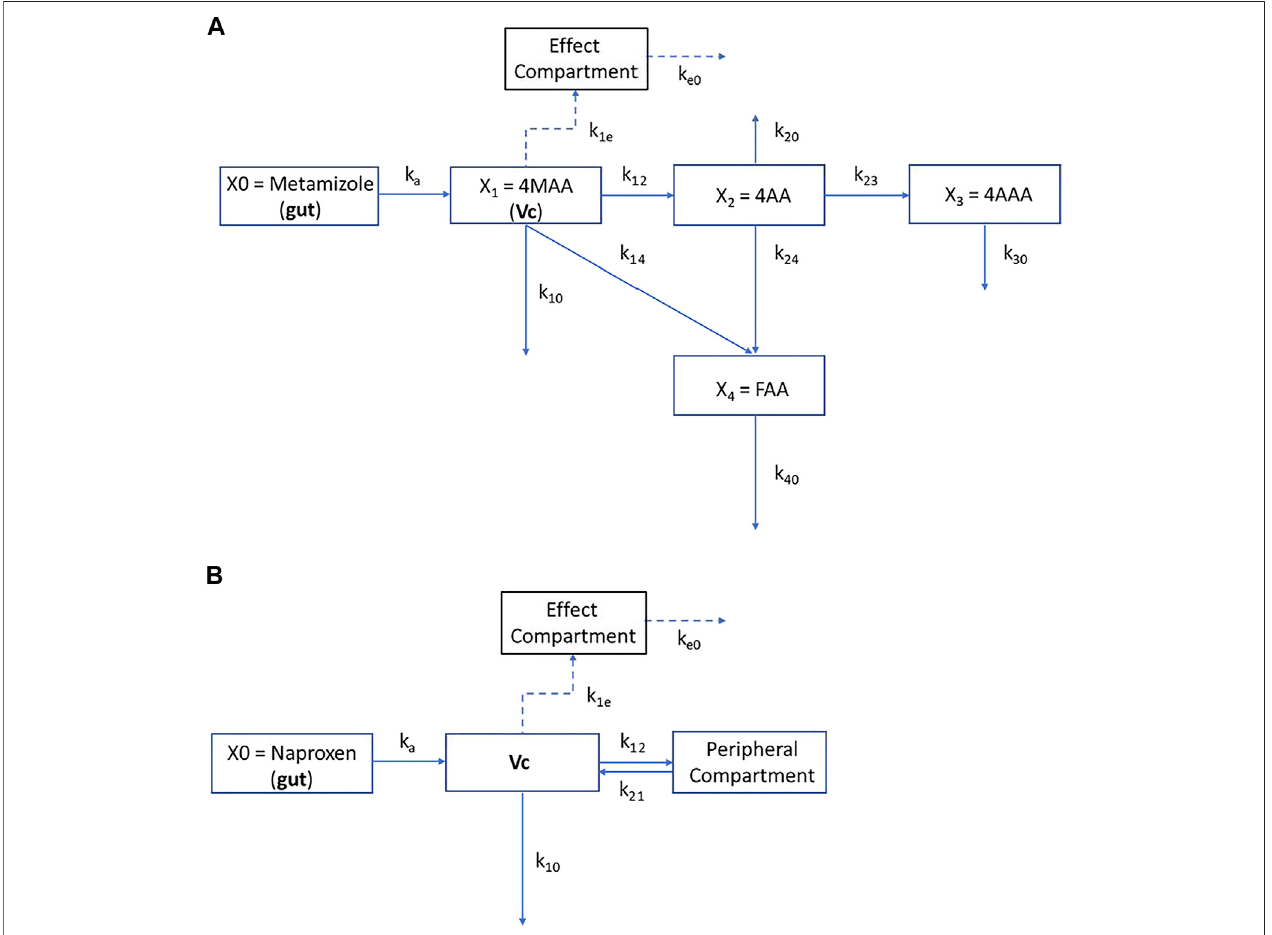
FIGURE 2 | Compartmental structures of the PKPD models for metamizole metabolites (A) and naproxen (B) . Dosing of drugs was assumed to the gut compartment